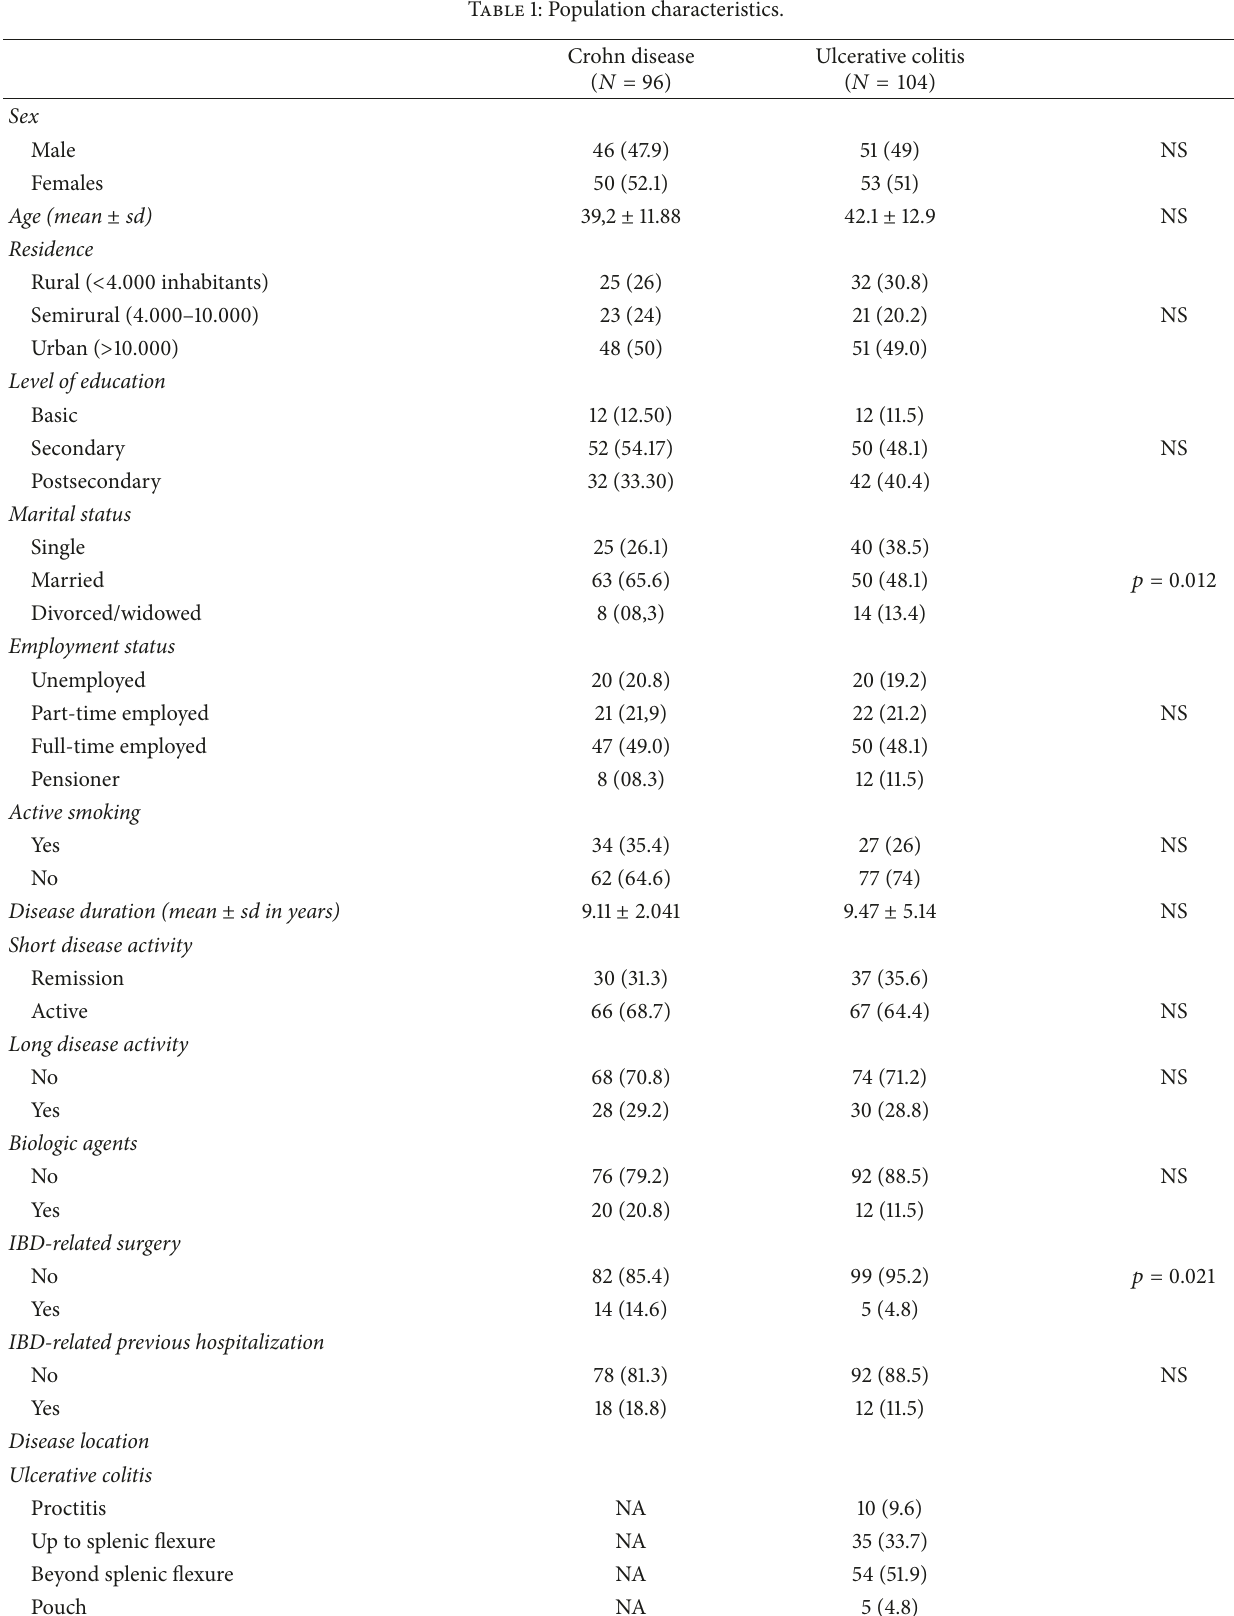
Table 1: Population